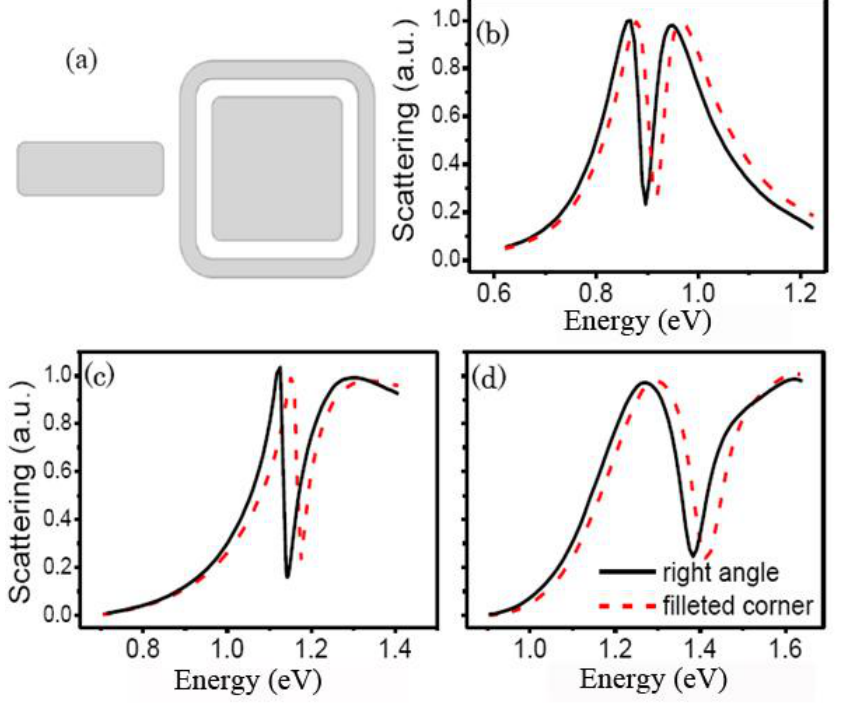
Figure 9. ( a ) Cross section of the CSRD nanostructure with wedge-shaped gap; ( b , c ) Scattering spectra of the RCSRD with W